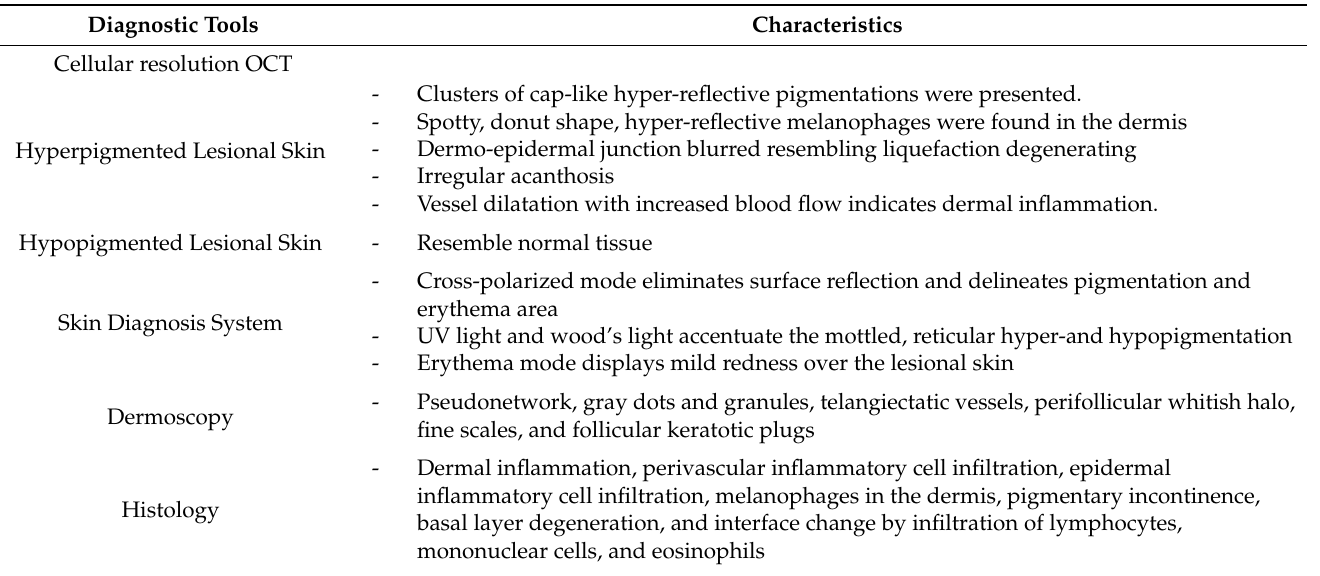
Table 2. Multimodality features of Riehl’s Melanosis with high-resolution OCT, skin diagnosis system, dermoscopy, and